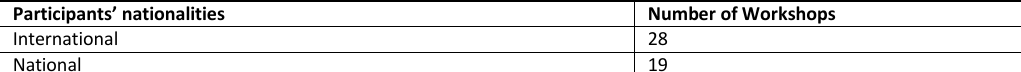
Table 8 The number of workshops across workshop participants’ nationalities